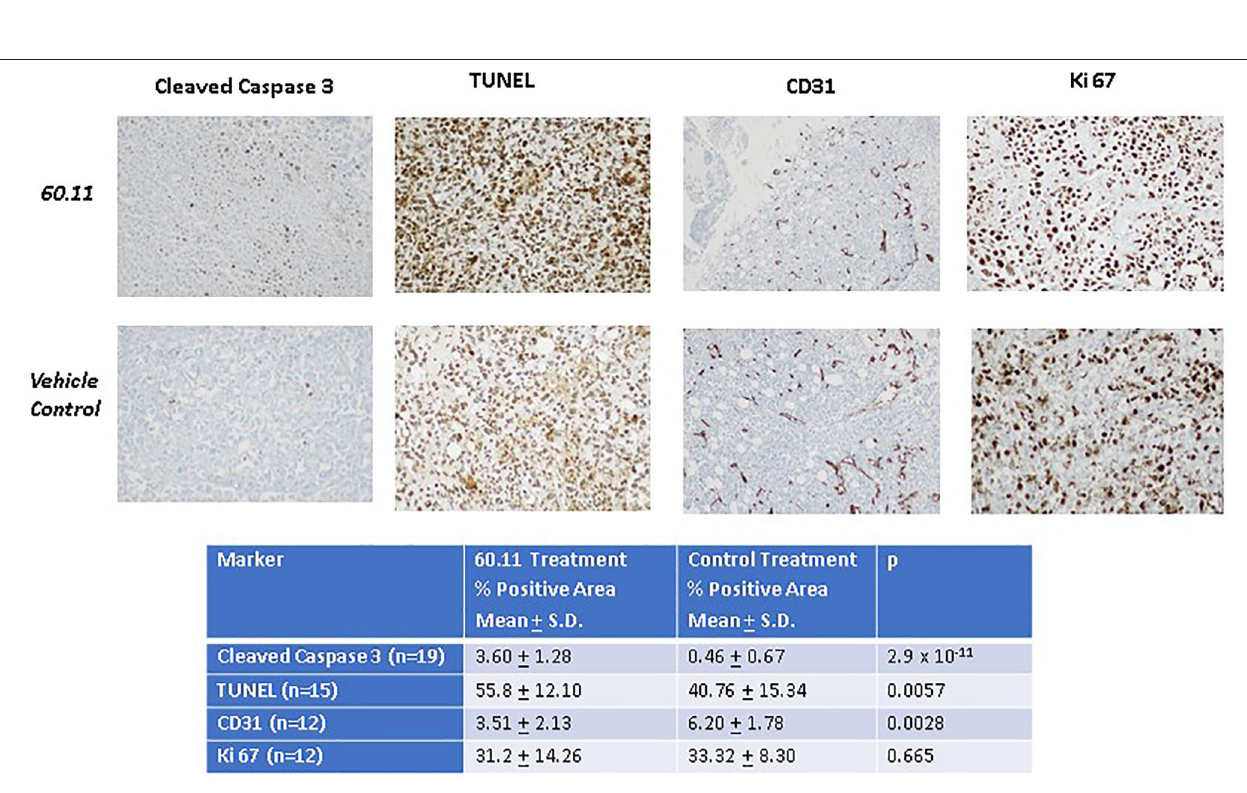
FIGURE 6 | Therapy with 60.11 increases apoptosis and reduces neovascularization in mesothelioma. Representative histologic images (20 × original magnification) of tumors obtained from control and 60.11 treated mice stained with cleaved caspase 3, TUNEL, CD 31, and Ki 76 are shown. Positive immunohistochemical reactivity is indicated by brown stain. Quantitative analysis of staining intensity is shown in the inset. N , number of microscopic fields selected for